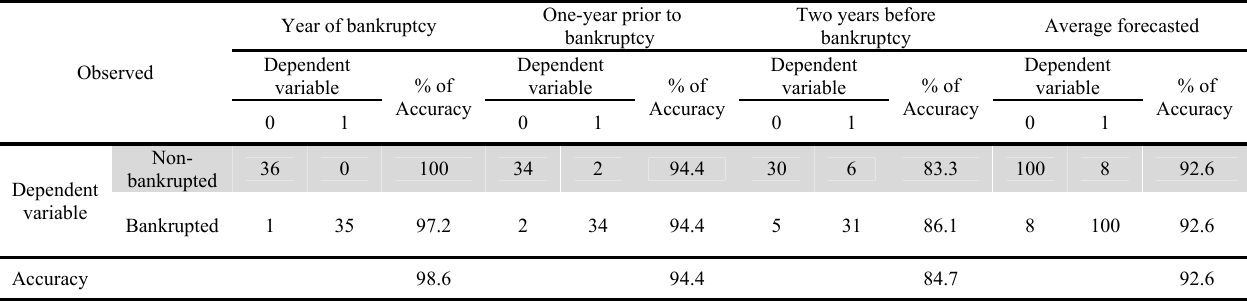
The results of the likelihood of bankruptcy based on logistic regression